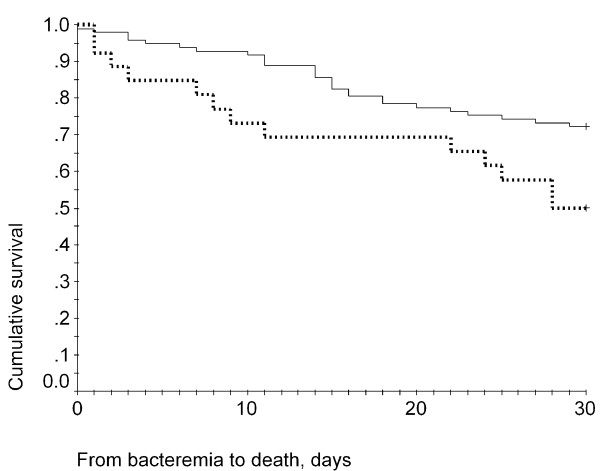
Kaplan-Meier survival curves of high-MIC and low-MIC group. Kaplan-Meier survival curves of patients with nosocomial MRSA bacteremia who were infected with high-MIC isolates (lower line) or low-MIC isolates (upper line). Log-rank test: p = 0.0232